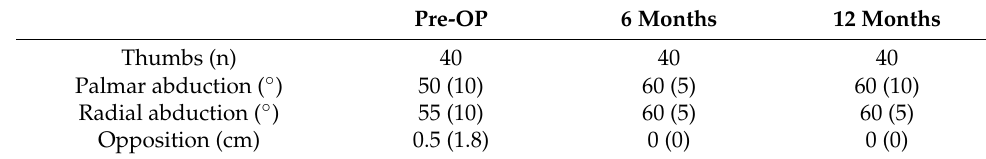
Figure 5. Key-pinch strength outcomes: ( a ) absolute values and ( b ) difference between the value of the operated hand and the contralateral one, which was solely calculated in unilateral cases (n = 34). * is indicating a p -value of 0.0001 and ** represents <0.0001. Statistical outliers are presented using a small circle. Table 2. Range of motion (ROM)